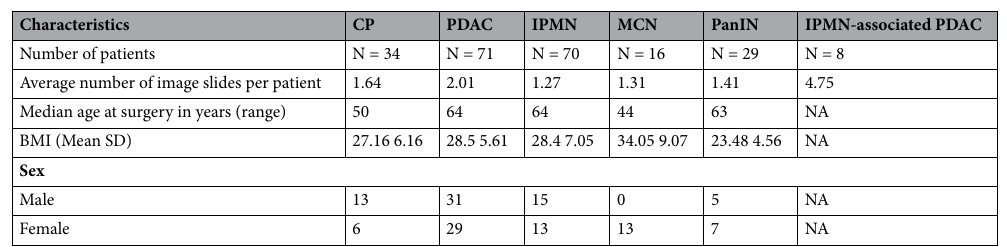
Table 1. A summary of clinical characteristics of the patient cohort. Missing values were excluded when computing summary statistics in each category.